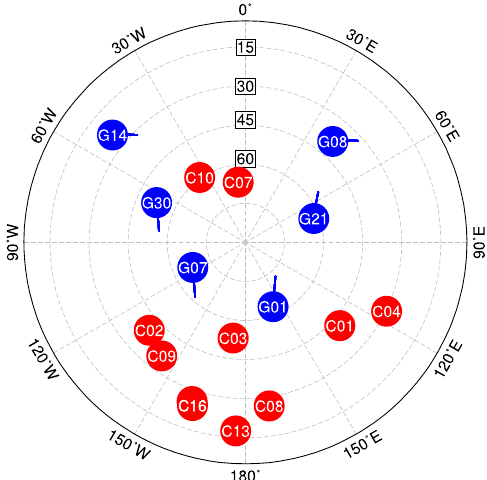
The warning indicators are in bold in the table.